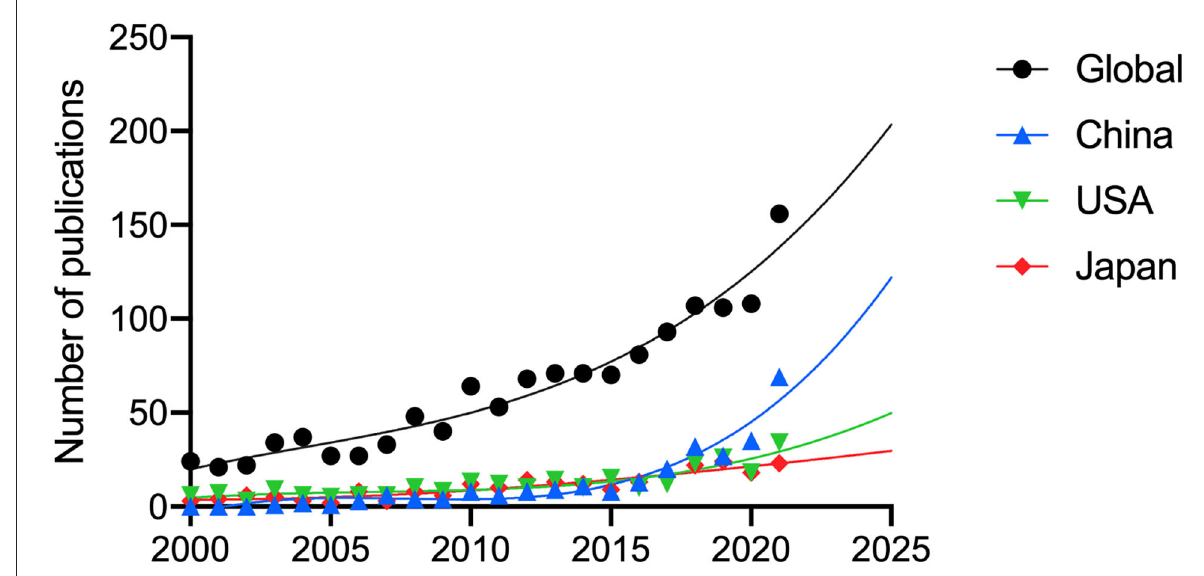
FIGURE2 The publication trends and prediction curve of global and countries which had the most publications of pathologic myopia since 2000. (A) Global. (B) China Mainland. (C) USA. (D)